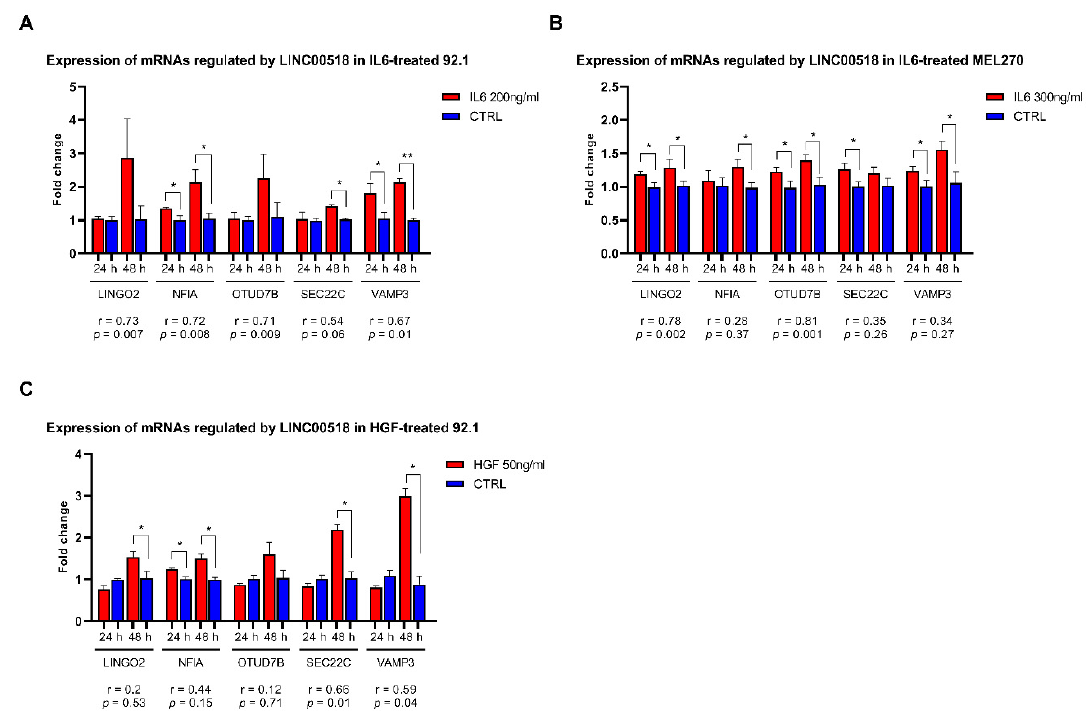
Figure 8. Expression of mRNAs regulated by LINC00518 after EMT induction in UM cells. Expression analysis in: ( A ) IL6-treated 92.1 cells; ( B ) IL6-treated MEL270 cells; ( C ) HGF-treated 92.1 cells. For each mRNA, the r-value and the associated p -value measuring correlation of expression with LINC00518 are reported. Each experiment was performed in three in vitro replicates. *: p -value < 0.05; **: p -value < 0.005.